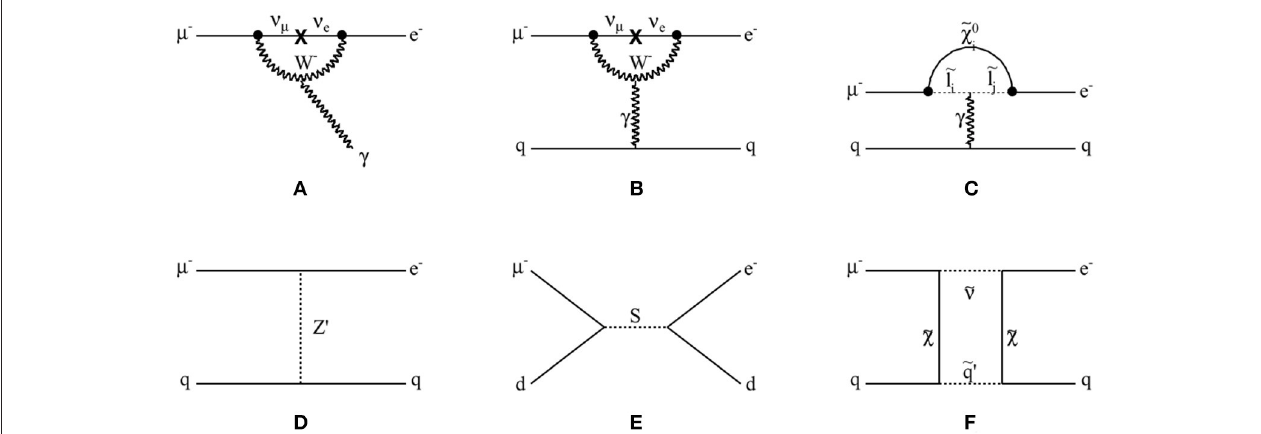
FIGURE 1 | The diagrams of cLFV processes, (A) for µ + → e + γ , and (B–F) for µ − + N → e − + N . (A) SM process due to massive neutrinos of µ + → e + γ , (B) SM process due to massive neutrino of µ − + N → e − + N , (C) SUSY process in a loop diagram, (D) vector boson exchange process, and (E) s-channel scalar boson exchange process, and (F) SUSY process in a box diagram of µ − + N → e − + N